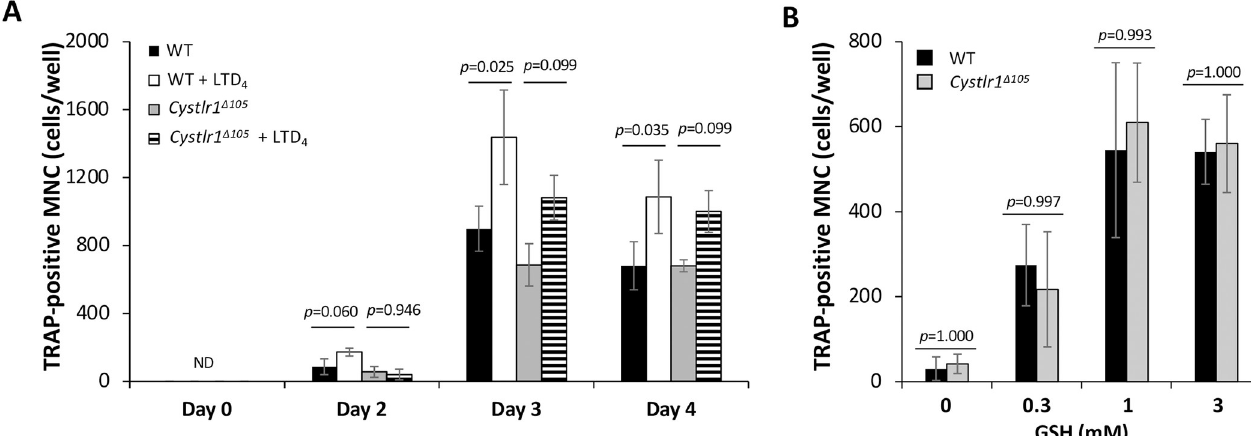
Fig 5. Leukotriene D 4 stimulates osteoclast formation via functional CysLT1R in vitro . (A) Leukotriene D 4 (LTD 4 ) stimulates osteoclast formation in WT and Cysltr1 Δ 105 BMM. BMM from WT and Cysltr1 Δ 105 were cultured with 100 ng/ml RANKL in vehicle (Ethanol) or 1 μ M LTD 4 for 4 days. WT, n = 3; Cysltr1 Δ 105 , n = 3. ND: not detected. (B) Glutathione (GSH) stimulates osteoclast formation in WT and Cysltr1 Δ 105 BMM. BMM from WT and Cysltr1 Δ 105 were cultured with 10 ng/ml RANKL at the indicated concentration of GSH for 3 days. WT, n = 4; Cysltr1 Δ 105 , n = 4. The number of TRAP-positive cells with more than three nuclei are